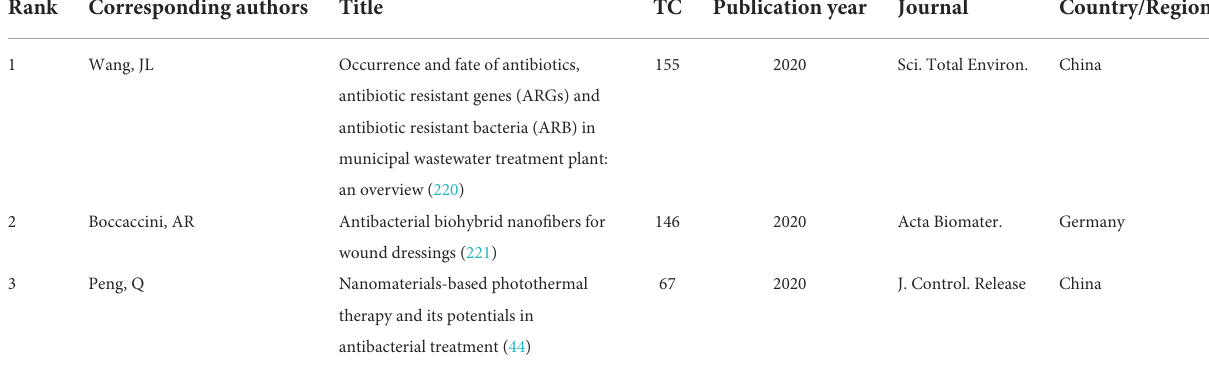
TABLE 7 The hot papers of ESI in ARB research field.